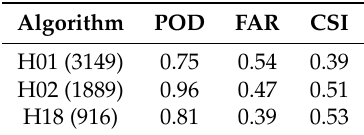
Table 5. Multicategory scores for Manaus for H01, H02 and H18. The number inside parenthesis concerns the number of matched pixel pairs for each algorithm.